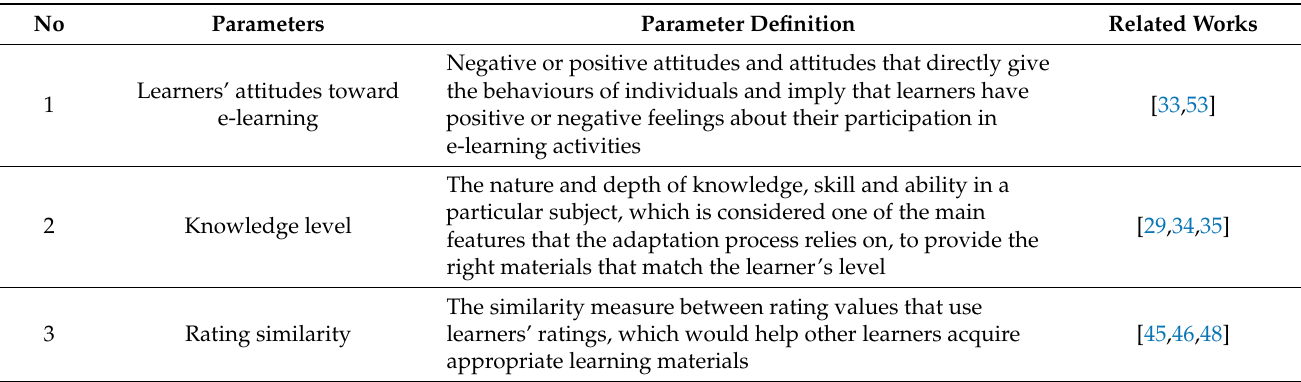
Table 1. eLearning